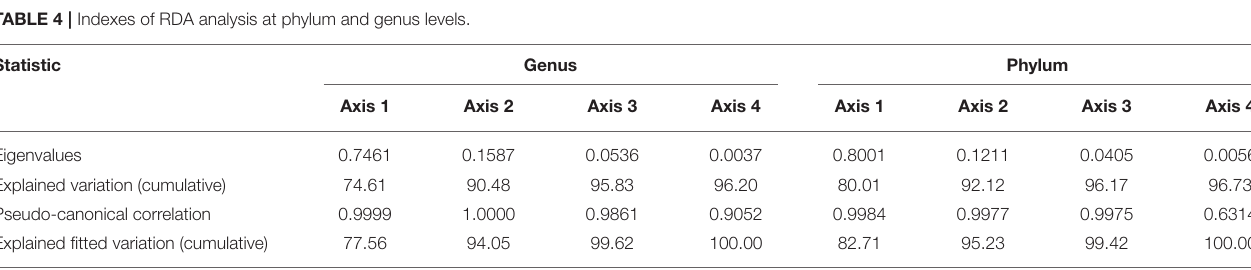
TABLE 4 | Indexes of RDA analysis at phylum and genus